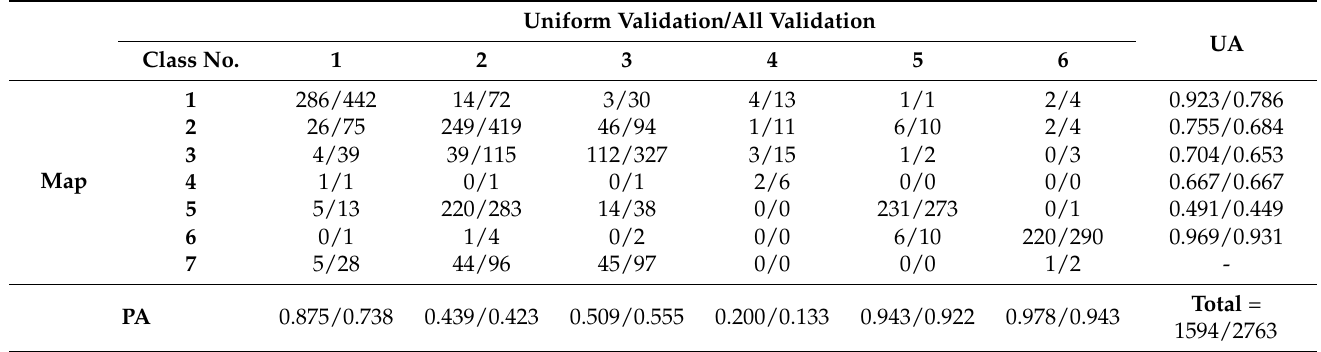
Table 9. Confusion matrix for GlobCover in 300 m scale.